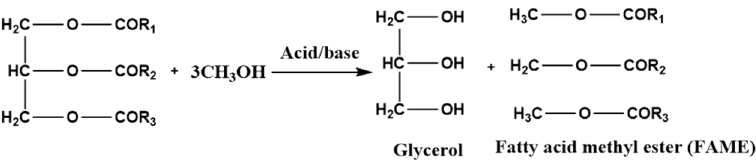
Figure 1. The chemical reaction scheme for transesterification of triglyceride fatty acid methyl ester (FAME) and glycerol as the by-product. Table 1. Summary of value-added products obtained from glycerol by catalytic routes.